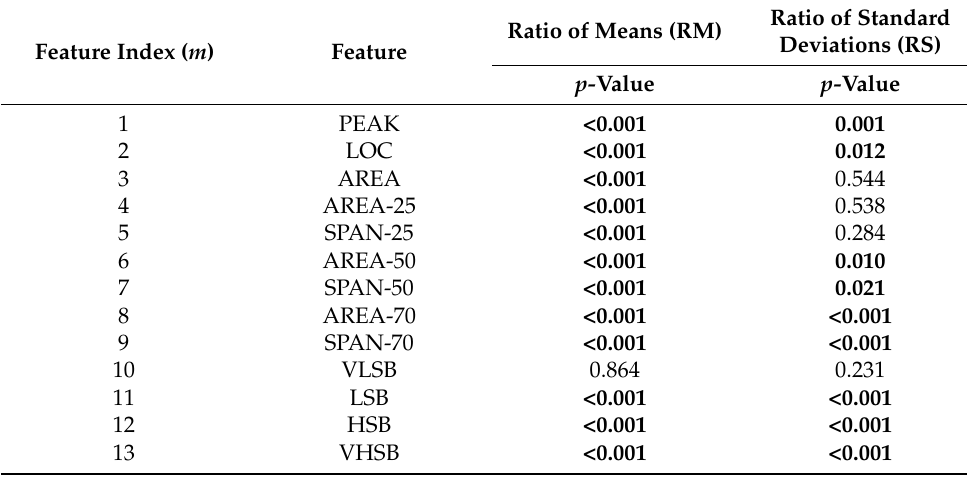
Table 8. Combined hypothesis testing (bold for p-value < 0.05, N =